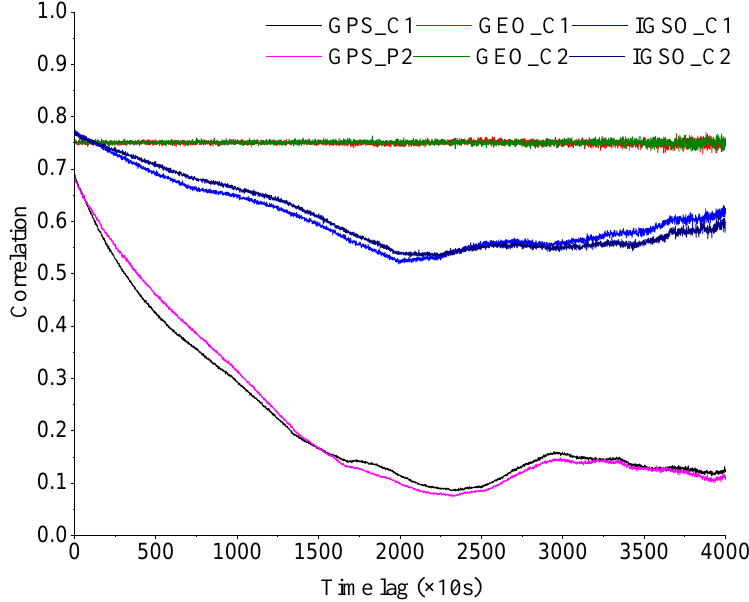
Figure 7. Trimble code measurement time correlations for GPS, and BeiDou GEO and IGSO satellites with a sampling interval of 10 s.